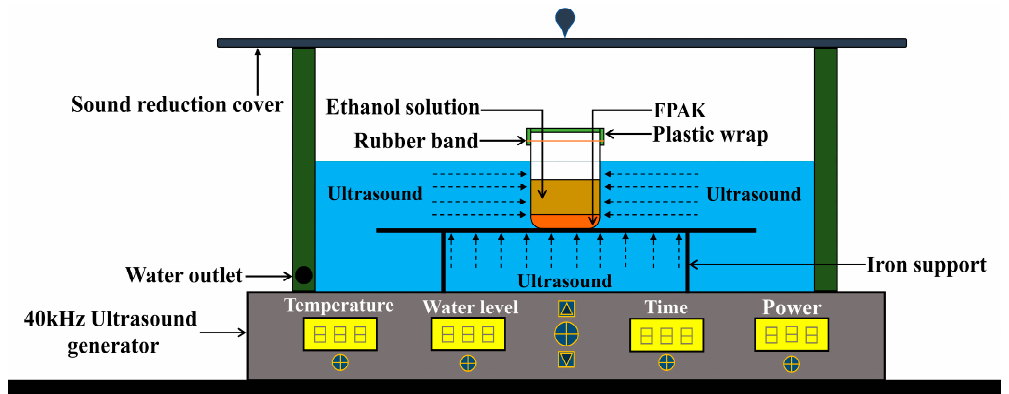
Figure 3. Diagram of experimental ultrasonic-assisted extraction device.